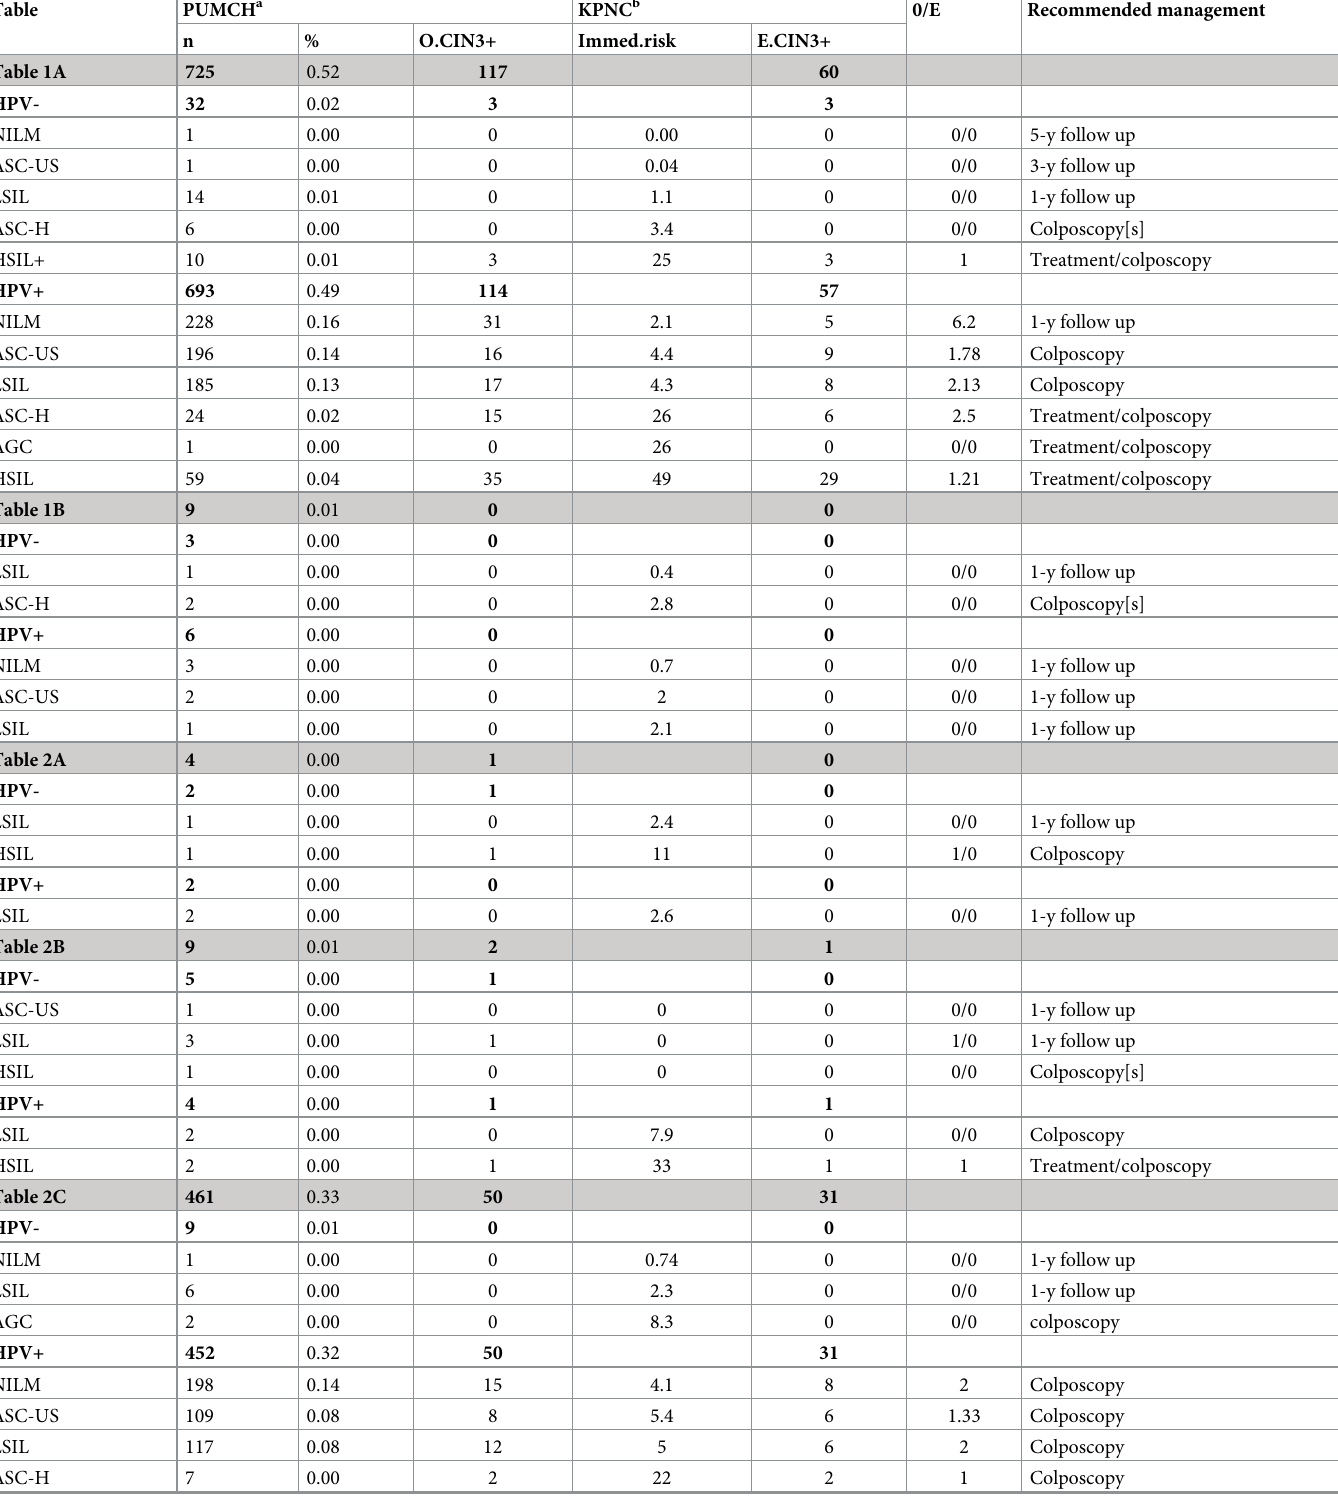
Table 6. Portability of KPNC risks and risk-based management to the PUMCH